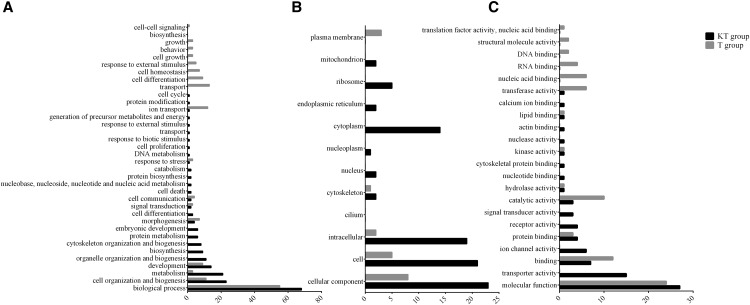
Differences between KT-treated and T-treated fish at 30 min post-injection in the representation of DE genes in the gene ontology (GO) classes for each ontology: A. Biological Process, B. Cellular Component and C. Molecular Function. Enriched GO terms were obtained for downregulated transcripts for each treatment group and mapped to a total of 127 GO slim ancestor terms with CateGOrizer.